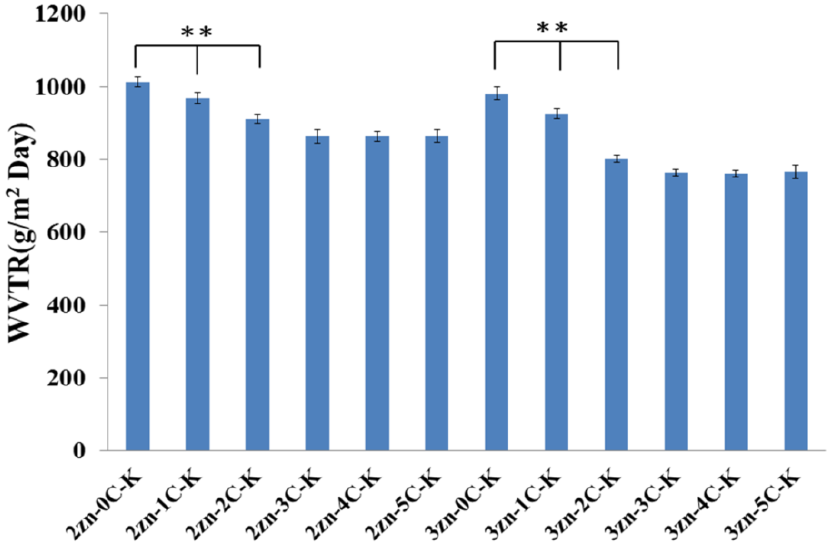
Figure 5. Air permeability of functional antibacterial knitted fabrics as related to the twist coeffi- Figure 4. Water vapor transmission rate of functional antibacterial knitted fabrics as related to cient. Note: data shown as mean standard deviation (SD) ( n = 12). ** p < 0.01. Note: data shown as mean standard deviation (SD) ( n = 12). ** p < twist coefficient. Note: data shown as mean standard deviation (SD) ( n = 3). ** p < 0.01.